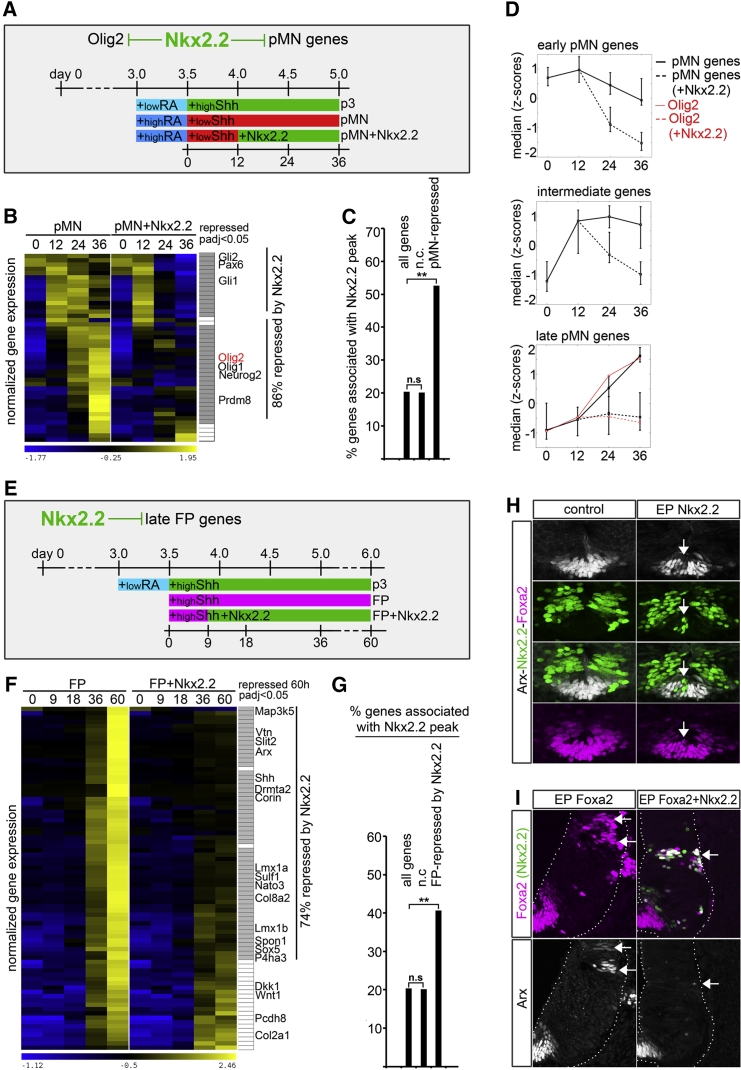
Nkx2.2 Directly Represses Genes Expressed in Adjacent Domains(A–D) Nkx2.2 directly represses pMN genes independently of Olig2 downregulation. (A) Schematic of the experimental rationale. To test whether Nkx2.2 represses both Olig2 and other pMN genes directly, ESCs were differentiated to p3 or pMN identity using the indicated schedules of RA and Shh treatment. Ectopic Nkx2.2 expression was induced in pMN progenitors by the addition of doxycycline 12 hr after Shh was added (pMN + Nkx2.2). (B) Heatmap comparing the time course of gene expression in pMN and pMN + Nkx2.2 iNPCs. Genes characteristic of pMN identity defined in Figure 1D as “pMN” (red) were expressed higher in pMN compared with p3. The induction of Nkx2.2 in pMN conditions repressed 86% of these genes. Filled gray boxes adjacent to the heatmap indicate genes significantly downregulated compared with pMN (padj < 0.05). Genes with known pMN-restricted (pMN > p3) expression are indicated. See also Table S1, sheet 2B. (C) Nkx2.2 binding is associated with many pMN genes that are repressed by Nkx2.2 induction. 53% of the pMN genes repressed by Nkx2.2 induction are associated with the binding of Nkx2.2. By contrast only 20% of all genes or genes that do not change in expression in neural progenitors have associated binding sites (n.c). ∗∗p(X2) < 0.001, n.s, non-significant. (D) Median expression levels of genes induced at early (n(genes) = 5), intermediate (n(genes) = 16) and late (n(genes) = 17) times in pMN cells (solid lines). The lines represent the median values of the indicated groups of genes and the error bars correspond to the 10th and 90th percentile values of each group. Most genes are induced prior to Olig2 (red line), which is induced relatively late. Both the early and intermediate classes of genes are downregulated (dotted lines) by the time Olig2 is fully induced (24 hr).(E–I) Nkx2.2 directly represses late FP genes. (E) Schematic of experimental rationale. To test whether Nkx2.2 inhibits the elaboration of FP identity by repressing genes induced at late times in FP differentiation, ESCs were induced to p3 or FP identity. Ectopic Nkx2.2 expression was induced in FP progenitors by doxycycline addition 9 hr after Shh treatment. (F) Heatmap comparing the time course of gene expression in FP and FP + Nkx2.2 iNPCs. Genes characteristic of definitive FP identity (late FP genes) were selected by identifying genes expressed at higher levels in FP than in p3 progenitors, induced to maximum levels at 60 hr (Figure S3). Genes with known FP-restricted expression are indicated. The induction of Nkx2.2 in FP conditions repressed 74% of these genes. Filled gray boxes adjacent to the heatmap indicate genes significantly downregulated in FP + Nkx2.2 compared with FP (padj < 0.05) at 60 hr. See also Figure S3 and Table S1, sheet 2F. (G) Nkx2.2 binding is associated with many of the FP genes that are repressed by Nkx2.2 induction. 40% of the FP genes repressed by Nkx2.2 induction are associated with the binding of Nkx2.2. ∗∗p(χ2) < 0.001, n.s, non-significant. (H) Nkx2.2 represses the late FP marker Arx in vivo. Nkx2.2 (green) was electroporated ventrally in ovo into the chick neural tube at HH8 and the expression of Arx (white) and Foxa2 (purple) was analyzed 48 hr later. At the ventral midline of experimental sample, Nkx2.2-expressing cells contained substantially lower levels of Arx expression (arrows). (I) Nkx2.2 acts downstream or in parallel to Foxa2 to repress late FP marker expression in vivo. Foxa2 or Foxa2 and Nkx2.2 were electroporated laterally into the chick neural tube at HH12 and the expression of Arx was analyzed 48 hr later. Foxa2 (purple) induces Arx expression (white) in intermediate/dorsal progenitors, in a cell-autonomous manner (arrows). By contrast, co-expression of Nkx2.2 (green) abolishes Foxa2-induced induction of Arx (arrow). The dotted lines indicate the outlines of the neural tube.